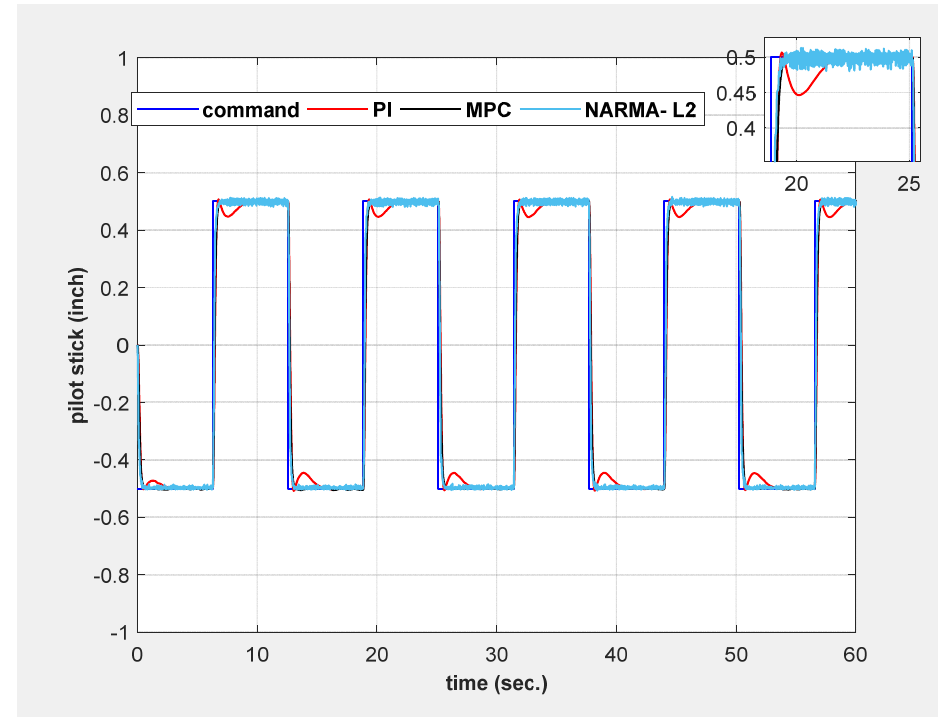
Figure 17. Pilot stick square wave response.